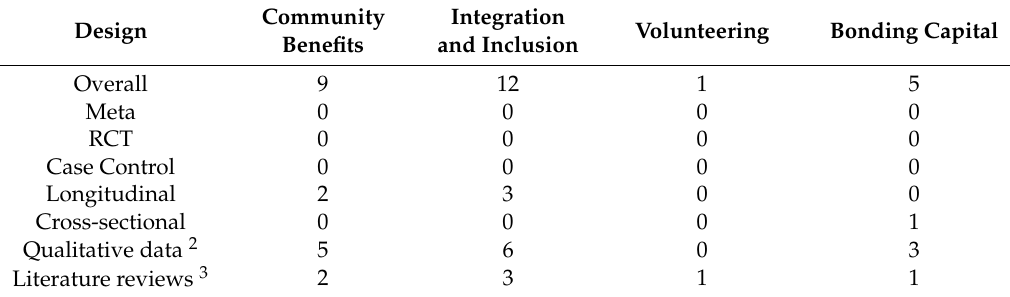
Table 7. Design of studies within active citizenship impacts 1 .